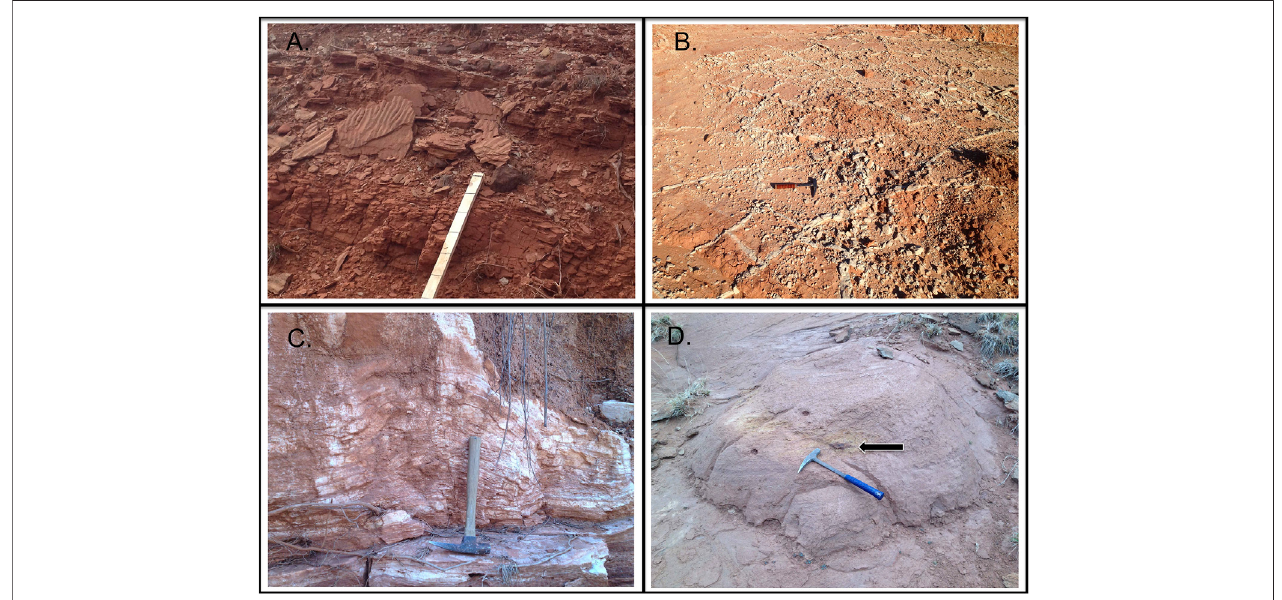
FIGURE 4 | (A) Rippled fi ne sandstone from strata in the sand- fl at facies of the lower Quartermaster Formation from exposures in the stratigraphic section near Dickens, TX. The staff beneath the rippled fl agstones has 10 cm graduations. (B) Fine-sand fi lled desiccation cracks in red mudstones of the sand- fl at facies from exposures in the stratigraphic section exposed in Caprock Canyons State Park. The rock hammer near the center of the photograph is 30 cm long. (C) Domal, cryptalgal, gypsum strata of the in the salt-lake facies belt of the Whitehorse Group strata sampled from the lower Caprock Canyons stratigraphic section located just east of the Caprock Canyons State Park. The rock hammer is 30 cm long. (D) Trough-cross bedded fi ne sandstones of the fl uvial facies belt from the upper exposuresoftheCaprock Canyons stratigraphic section. Thehammer intheforeground is40 cmlong.Thearrow ispointing toabrownish-redcrosssection ofthelong axis of a fossil branch or trunk. See text for further